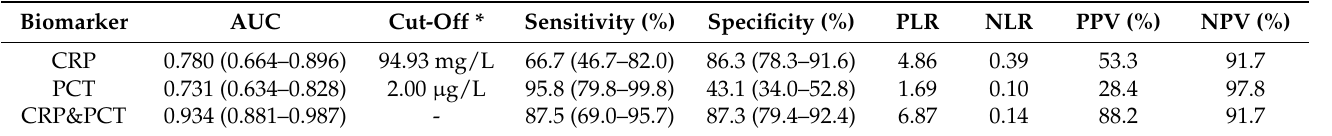
Table 3. Performance characteristics of CRP, PCT, and the combination of CRP and PCT in diagnosing the